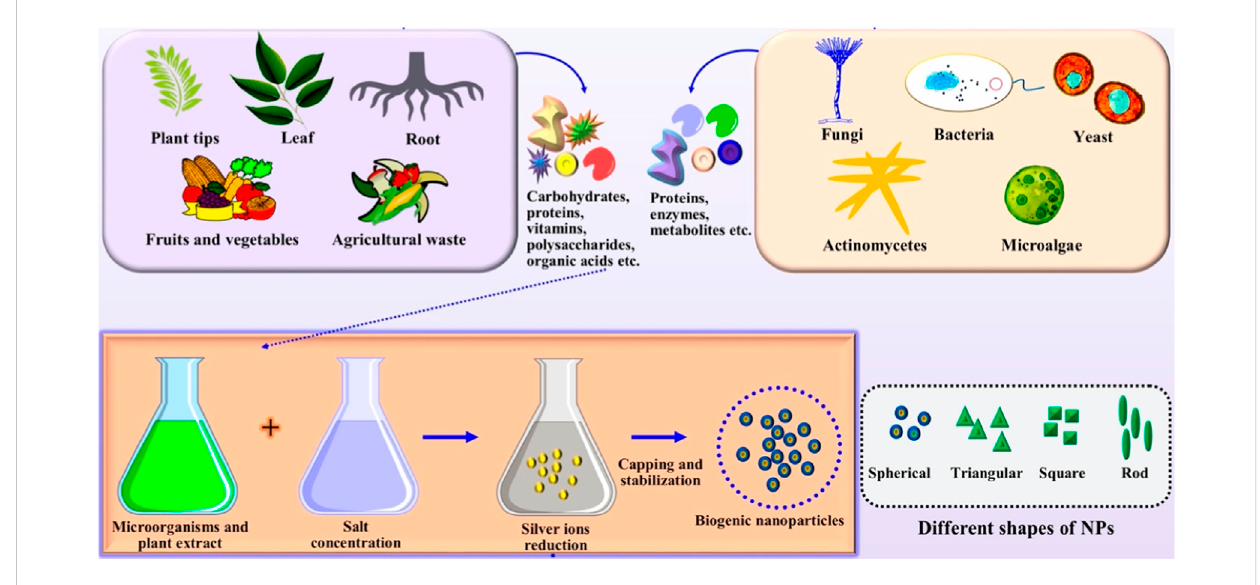
FIGURE 2 The synthesis of nanoparticles includes the extraction of various primary and secondary metabolites and subsequent reduction processes using appropriate ion concentrations. Depending on the process parameters used, the produced particles may have different shapes. Adapted from Ref (AliAhmed et al., 2020). CC BY